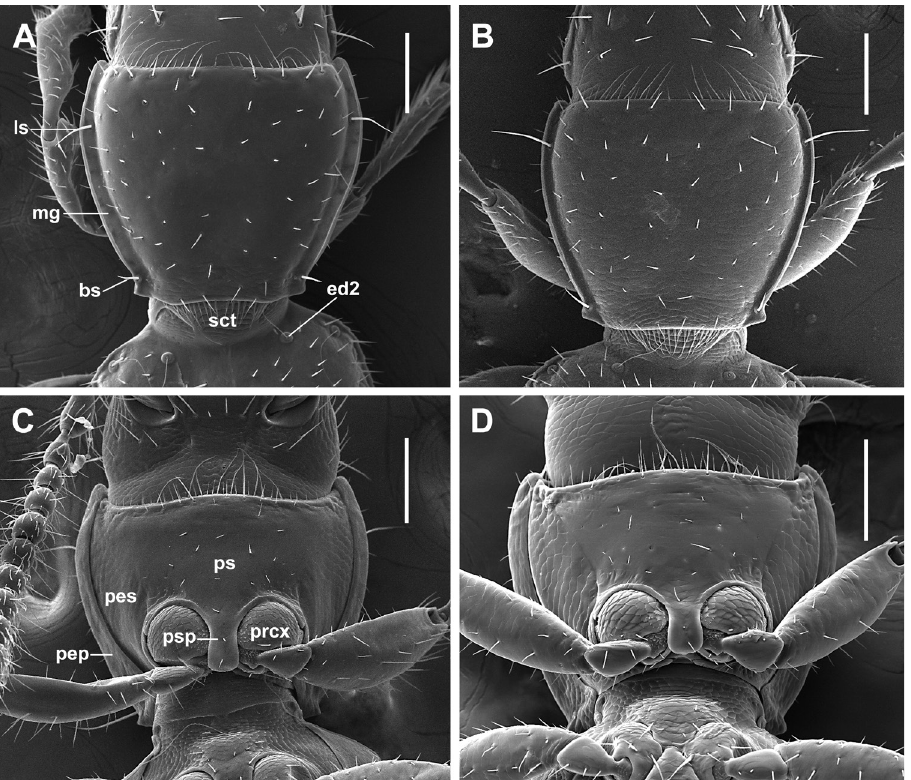
Figure 2. SEM illustrations of pronotum, dorsal aspect, and prothorax, ventral aspect, of Pelodiaetus spe- cies. A, C P. sulcatipennis B, D P. nunni . Abbreviations: bs – basilateral pronotal seta; ed2 – scutellar